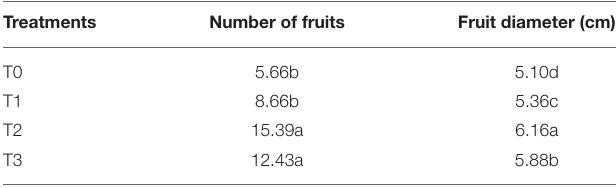
TABLE 3 | Number of fruits and fruit diameter with organic and organo-mineral fertilizer application. Treatments Number of fruits